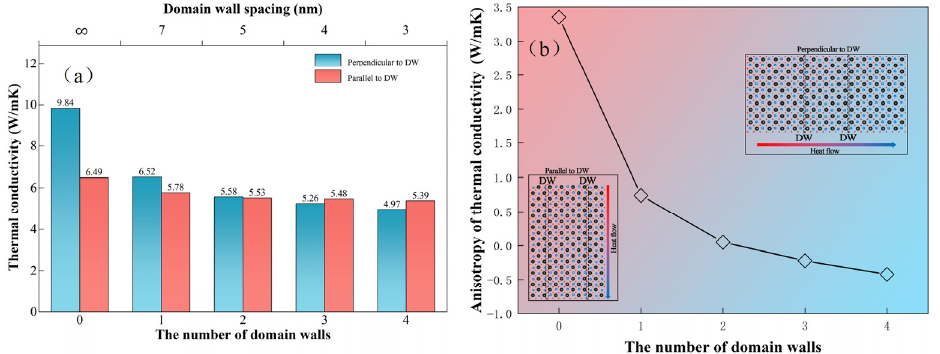
Figure 4. ( a ) The anisotropic thermal conductivity of multidomain KTN with the number of DWs at 300 K. The top x -axis indicates the variation of thermal conductivity by DWs spacing ( b ) The anisotropic thermal conductivity along with the number of DWs and the schematic diagram of the model with different heat flow directions.